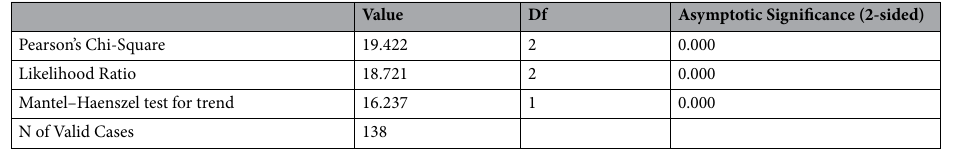
Table 4. Results of a Chi-square test of independence for different age groups (pre-kindergarten, schoolers, and adults) and the direction of orientation in hand gestures.